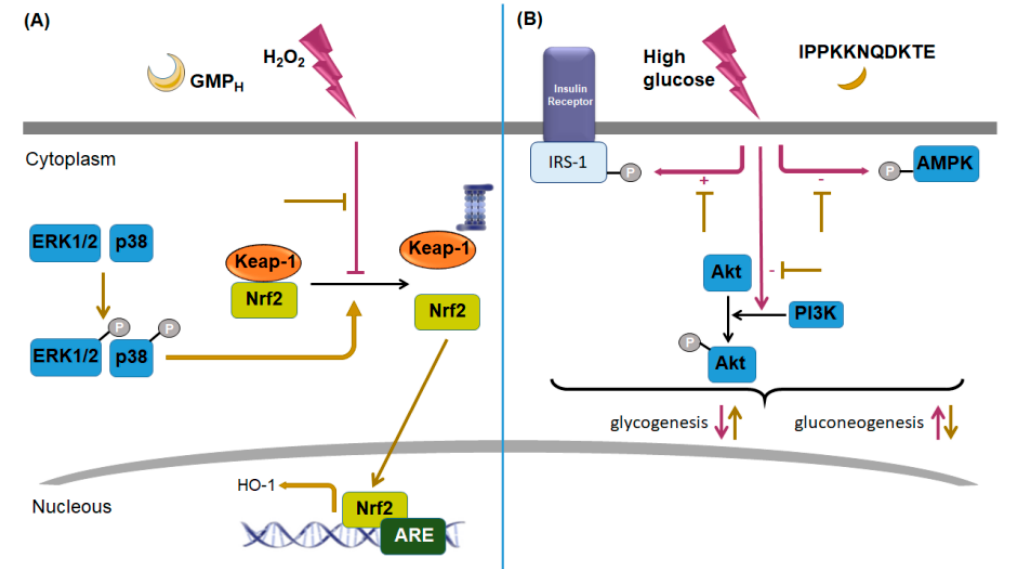
Figure 7. Signaling pathway involved in papain-hydrolyzed glycomacropeptide modulation on HepG2 cell response to hydrogen peroxide or to high-glucose conditions. ( A ) A papain-hydrolyzed glycomacropeptide (GMP H ) shows hepatoprotection and antioxidant activity on hydrogen peroxide (H 2 O 2 )-induced oxidative damaged in hepatocytes HepG2. Via extracellular-signal-regulated protein kinase (ERK1/2) and mitogen-activated protein (MAP) kinase p38 activation (phosphorylation), GMP H blocks the inhibition of nuclear translocation of the nuclear factor erythroid 2-related factor 2 (Nrf2) induced by H 2 O 2 , and, as a consequence, increases heme oxygenase-1 (HO-1) expression. ( B ) The peptide IPPKKNQDKTE derived from GMP H improves impaired glucose metabolism in high-glucose-induced insulin-resistant HepG2 cells, by increasing glucose intake, promoting glycogenesis, and inhibiting gluconeogenesis. IPPKKNQDKTE blocks the increase in insulin receptor substrate-1 (IRS-1) phosphorylation, and the decrease in adenosine monophosphate (AMP)-activated protein kinase (AMPK) phosphorylation and phosphatidylinositol 3-kinase (PI3K)/protein kinase B (Akt) activation, induced by high-glucose conditions. P, phosphate group; Keap-1, kelch like E3 ubiquitin ligase complex-associated protein-1; ARE, antioxidant response element.